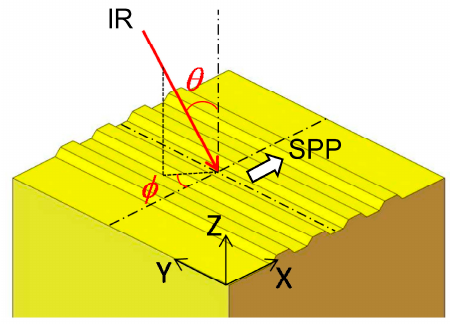
Figure 2. Schematic drawing of the incident light on the reflective grating. SPP: surface plasmon polariton.